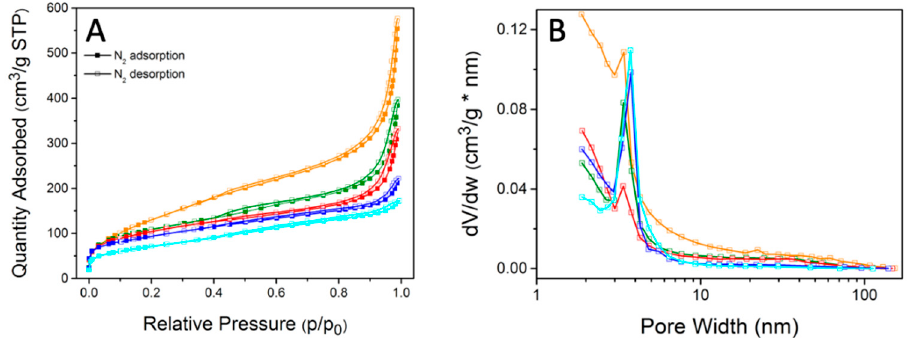
Figure 7. ( A ) N 2 adsorption/desorption isotherms registered for the TiO 2 NP samples as a function of temperature and duration time of the treatment. All the curves (type IV) are characteristic of mesoporous solids with H1-type hysteresis [37]. ( B ) Pore size distribution as dV/dw (cm 3 /g*nm) vs. pore width (nm) calculated by the Barrett-Joyner-Halenda (BJH) model on the desorption branch of isotherms for TiO 2 samples. TiO 2 samples are reported using following color code: TiO 2 _0 h (orange line), TiO 2 _2 h (green line), TiO 2 _8 h (red line), TiO 2 _16 h (blue line), TiO 2 _24 h (light blue line).